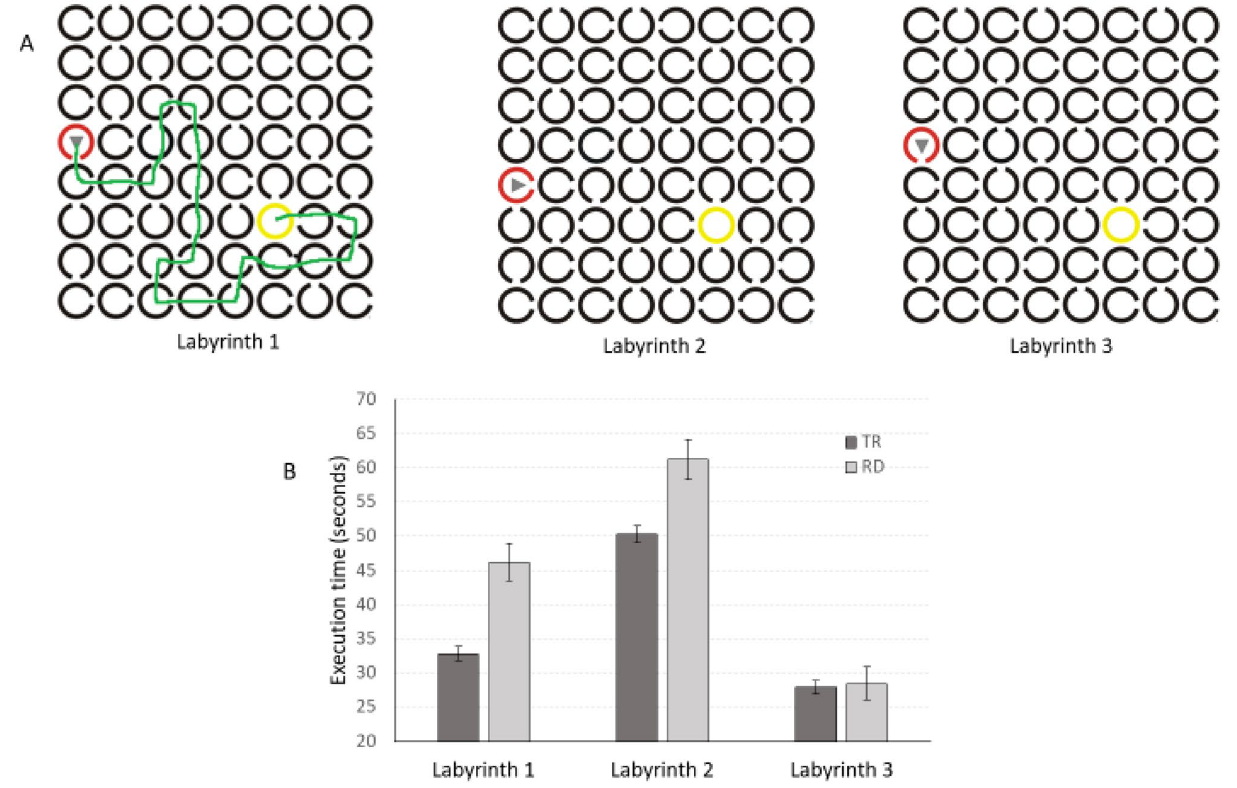
Figure 1. Panel ( A ) Representation of the three labyrinths that compose the visuo-spatial attention task. In the first labyrinth, an example of correct execution is represented; panel ( B ): Execution times (mean in seconds) in typical readers (TRs) and children with reading difficulties (RDs) in the three labyrinths. Error bars represent standard errors of the mean.